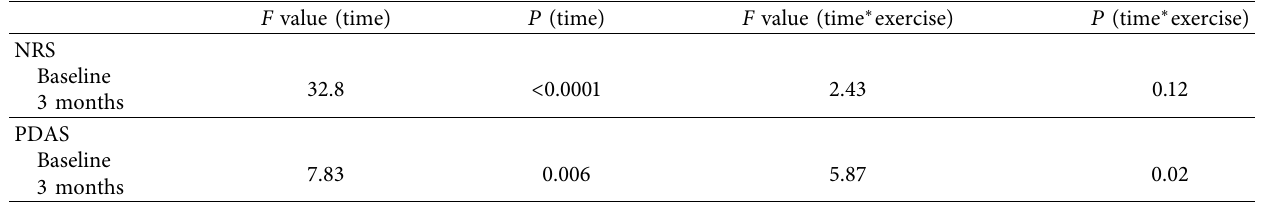
Table 3: Comparisons of changes in pain and disability between the control group and the exercise group during a 3-month follow-up. F value (time) P (time) F value (time ∗ exercise)